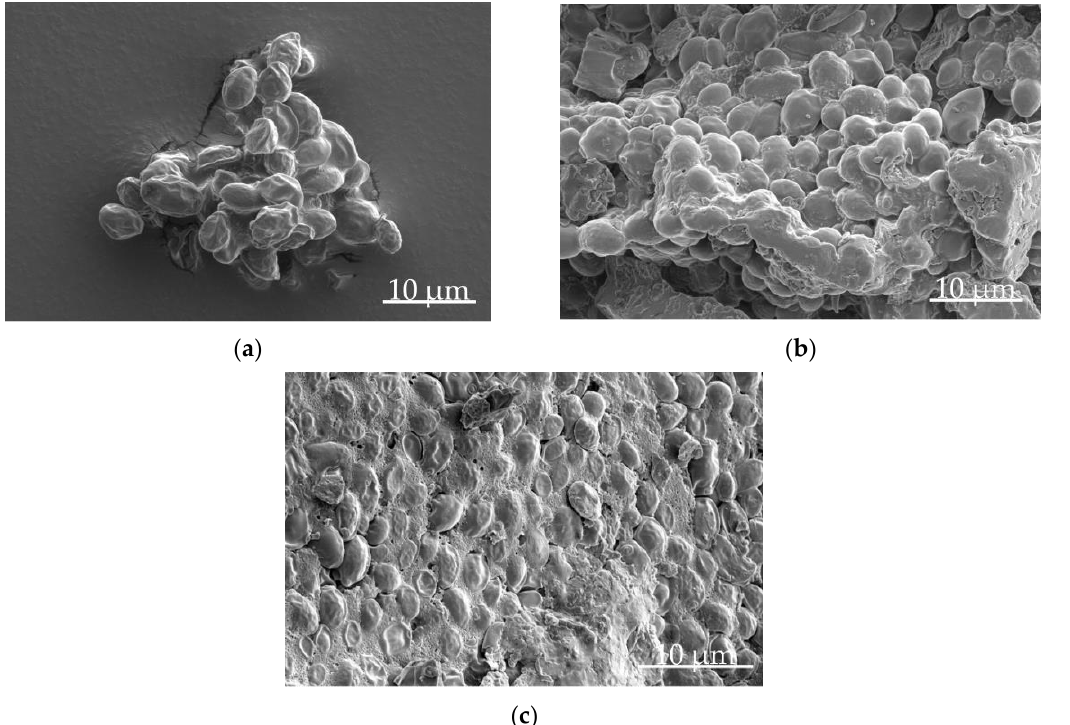
Figure 3. Scanning electron microscopy images of lyophilized yeast cells suspended in purified water ( a ) or a solution of trehalose and milk powder ( b ). The third image ( c ) shows the fracture surface of a tablet composed of compacted cells freeze-dried with trehalose and milk powder. Compaction stress was 200 MPa.